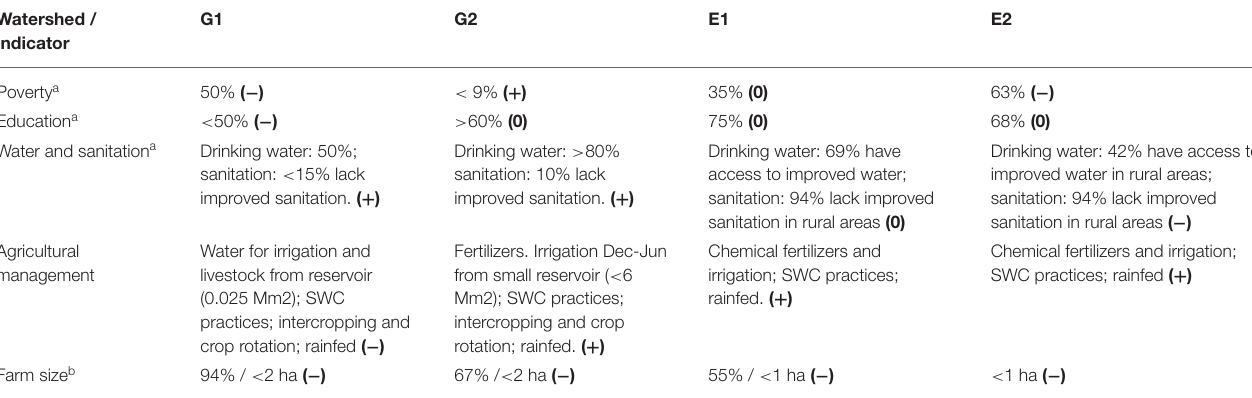
TABLE 4 | Indicator scoring on assets and use of assets for the four watersheds G1, G2, E1 and E2 [data derived from primary and secondary sources from: WFP (2012, 2014), Ghana Statistical Service (2013), Debevec et al. (2016a,b), IWMI (2016b), Amoah and Appoh (2017a,b), Central Statistical Agency (2017)]. Watershed / indicator